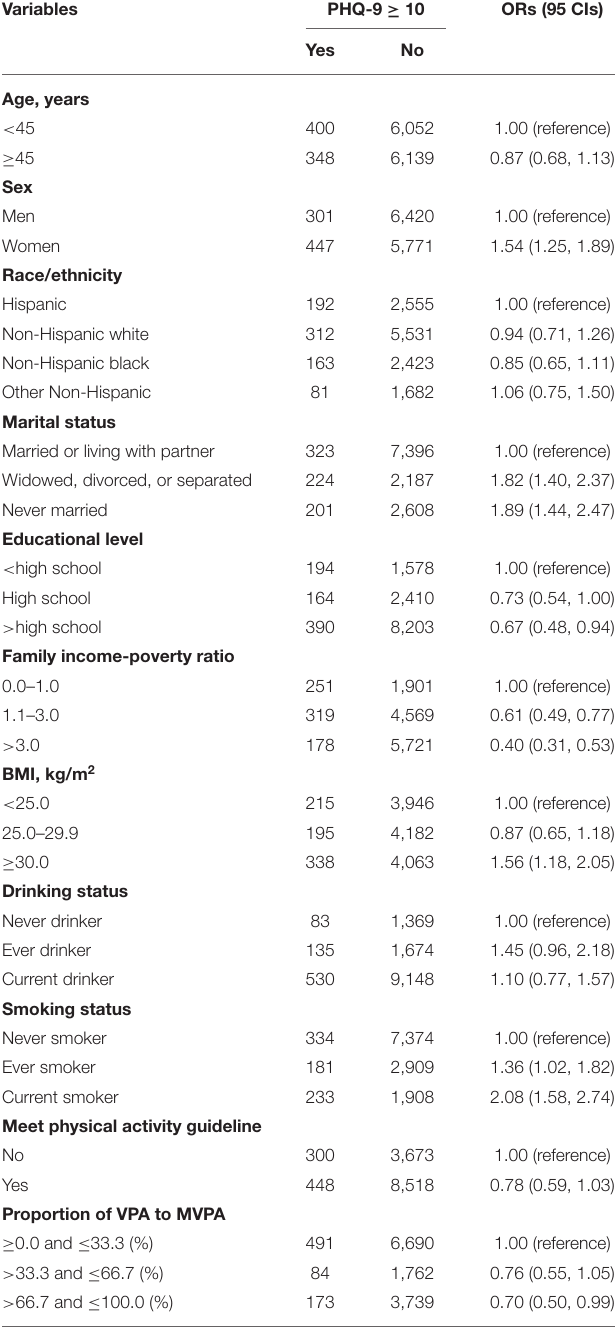
TABLE 2 | ORs and 95% CIs for depression of the proportion of VPA to MVPA and other covariates.